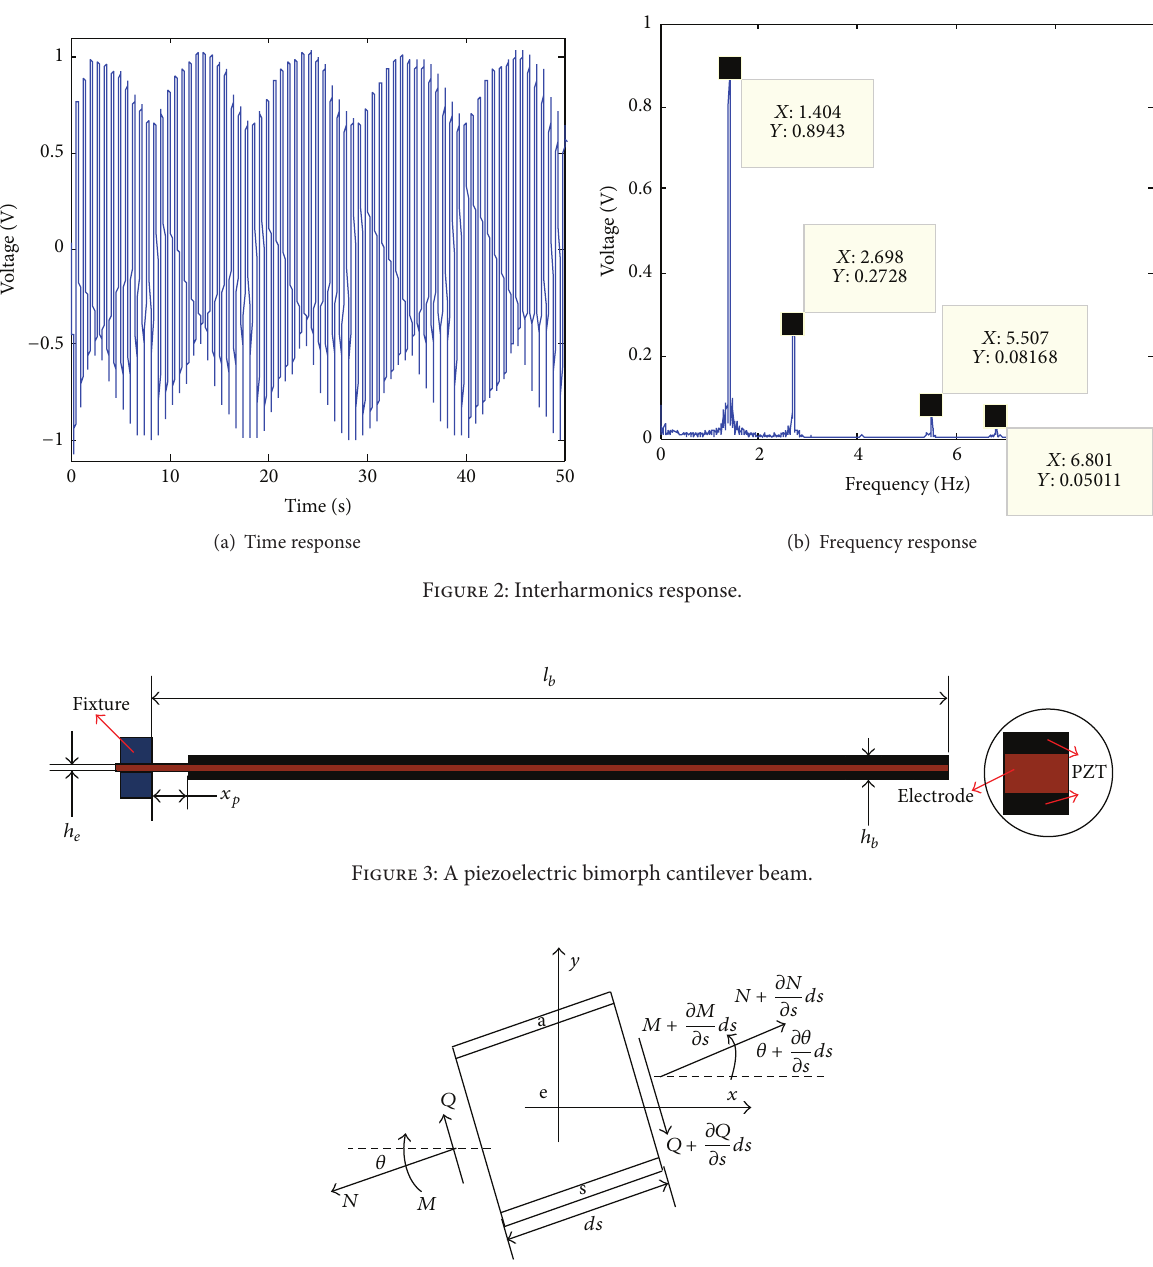
Figure 4: Infinitesimal element of the